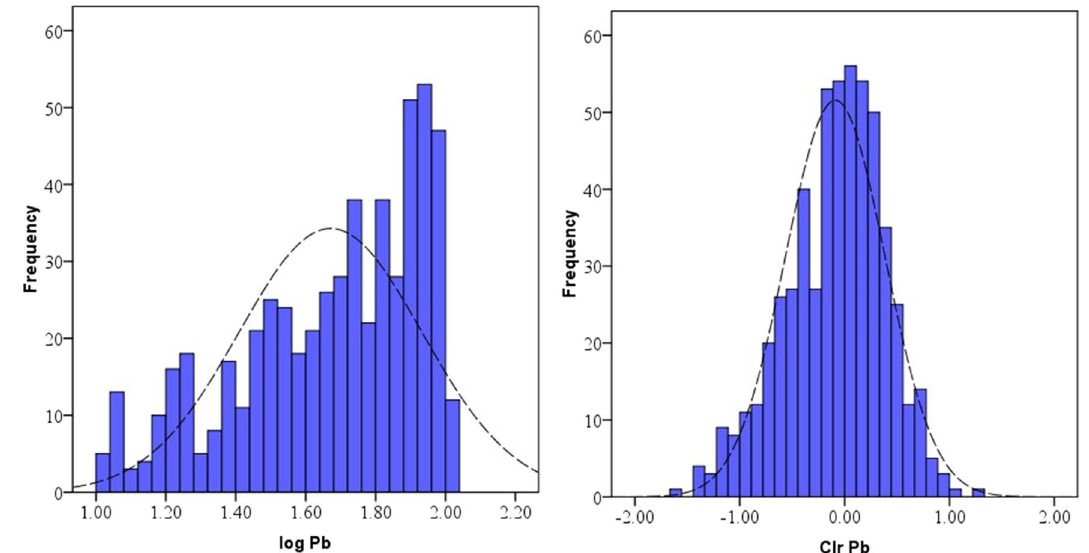
Figure 6. EDA plots for: (a) Pb original log-transformed data; (b) Pb clr-transformed data.